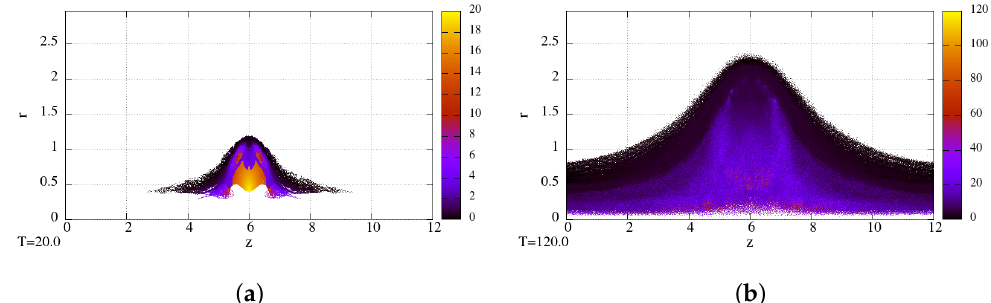
Figure 1. Injected beam coordinates at T = 20 ( a ) and T = 120 ( b ).